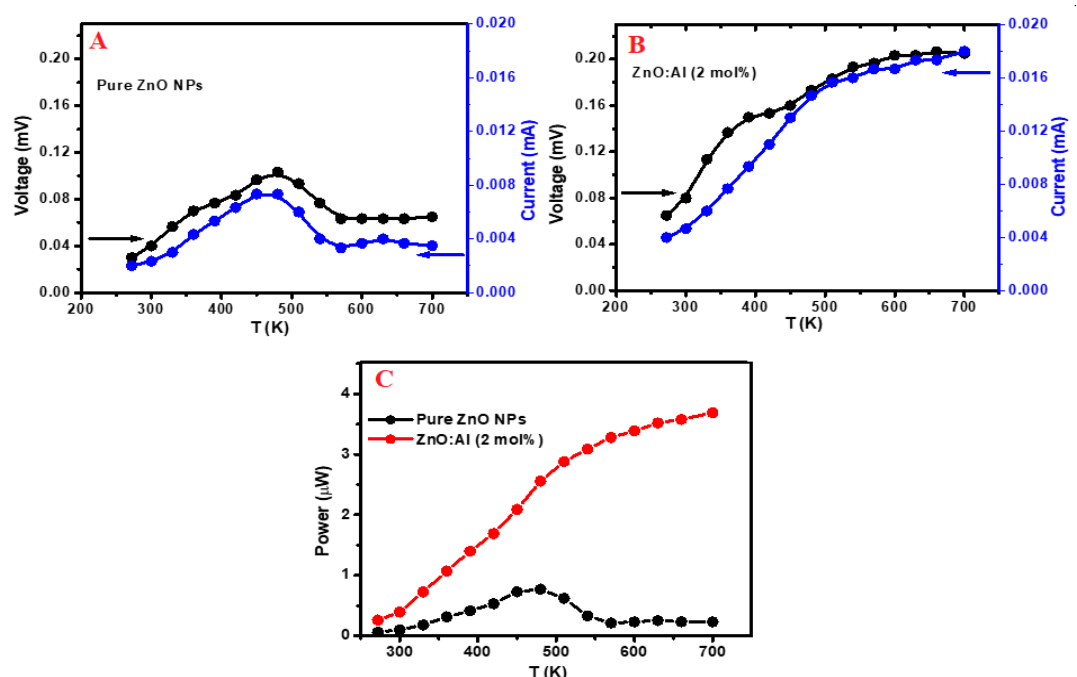
Figure 9. Power measurement analysis of the pure and the 2 mol % Al doped ZnO NSs. Voltage–current curves of the pure ZnO NSs ( A ), and voltage–current curves of the 2 mol % Al doped ZnO NSs ( B ), output power measurements variation between the pure and 2 mol % Al doped ZnO NSs samples ( C